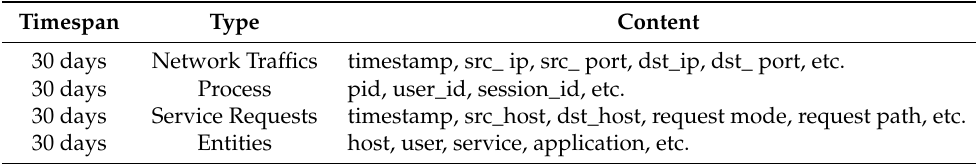
Table 5. Examples of events data collected by a national key R&D plan.